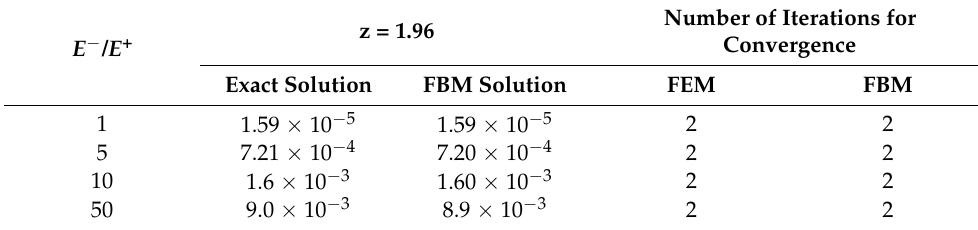
Table 1. Comparison of precision and